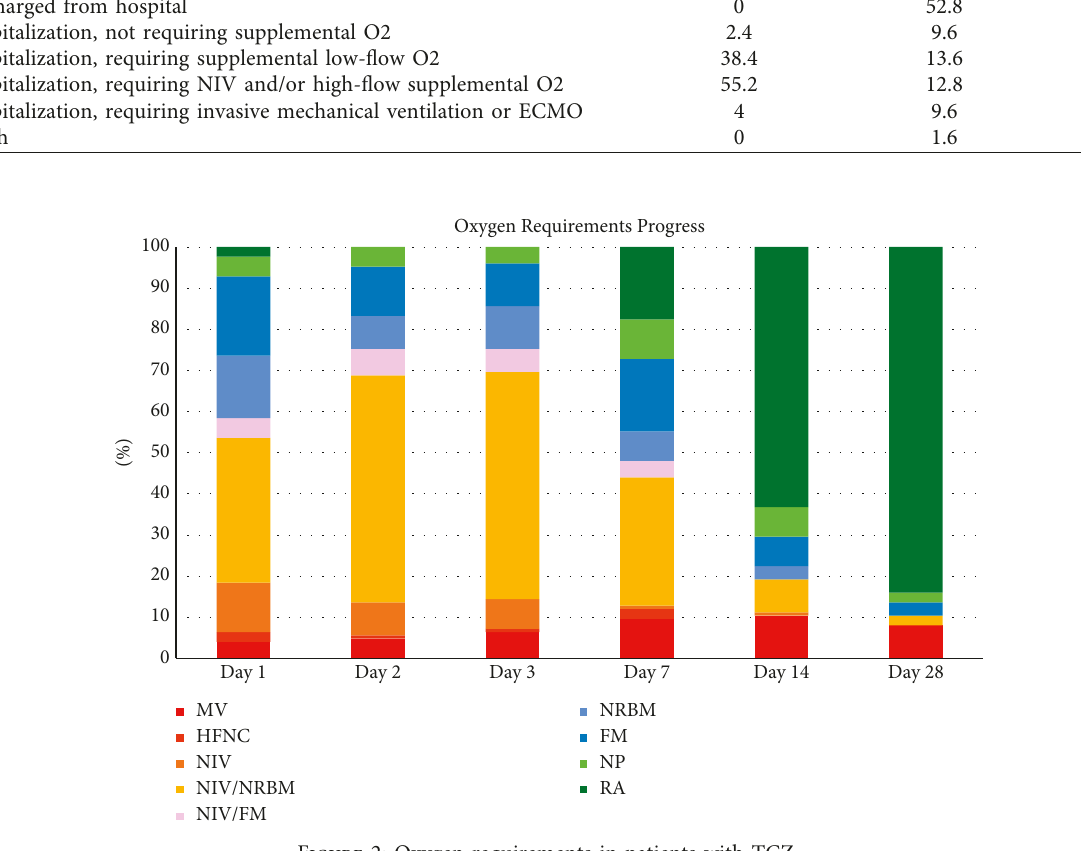
Figure 2: Oxygen requirements in patients with